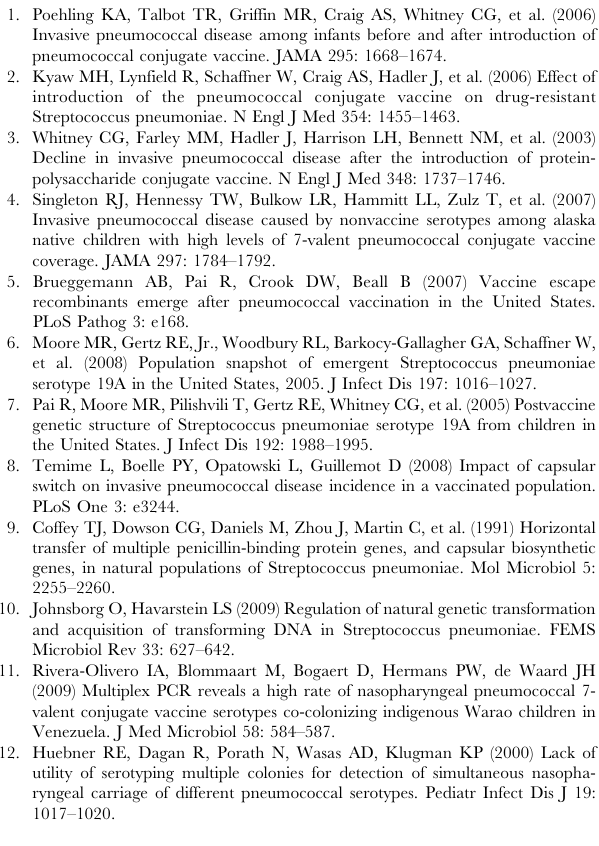
Multiple colonization by plyNCR RFLP and